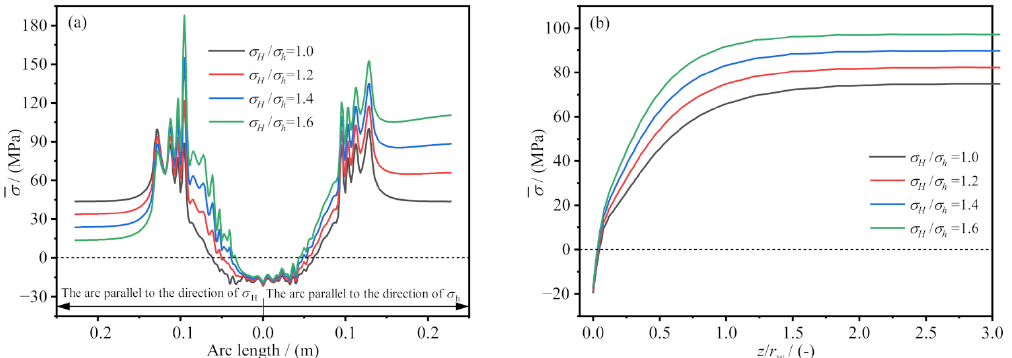
Figure 9. Average effective stress of the bottomhole rocks under different in situ stress ratio conditions. ( a ) The arc parallel to the direction of σ H and σ h ; ( b ) The line along the axis of the